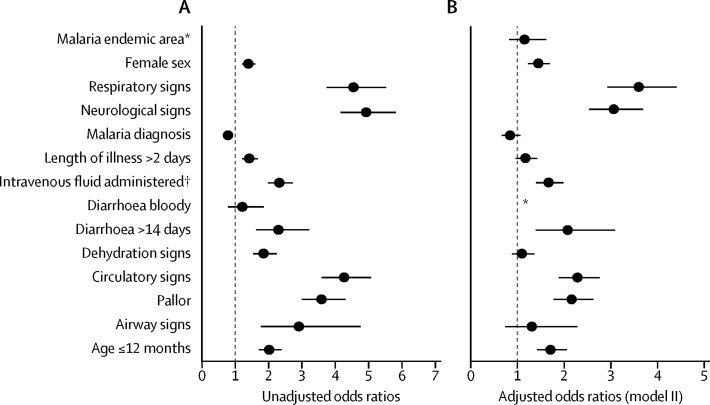
Risk factors for in-hospital mortality in children with diarrhoea and dehydration(A) Association of each covariable with in-hospital mortality in models using imputed data. (B) Association with in-hospital mortality after adjustment for all patient-level covariables. *Odds ratios not calculated. †Proxy measure for illness severity.